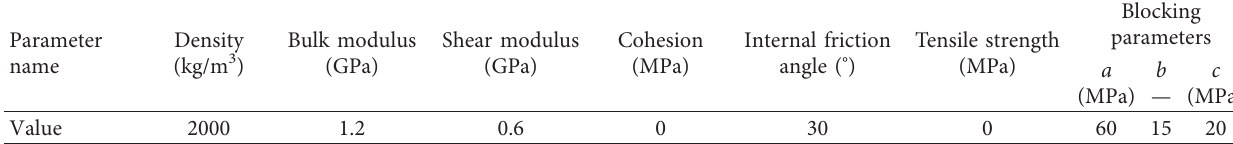
Table 2: Mechanical parameters of falling gangue in